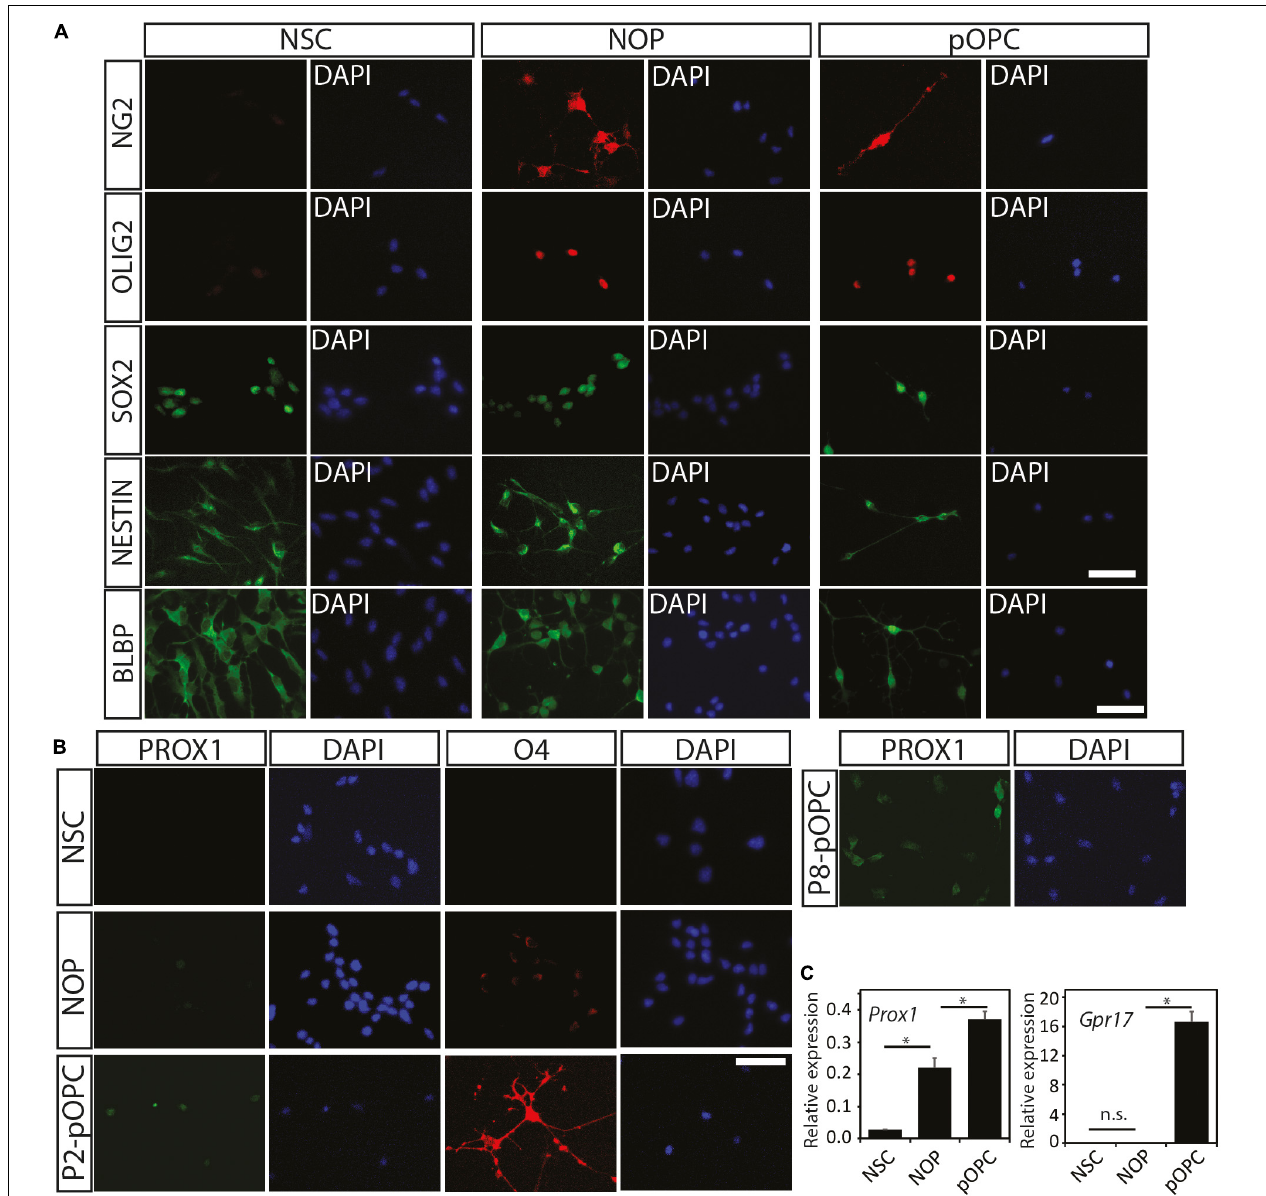
FIGURE 2 | Expression of oligodendroglial lineage markers among NSC, NOP, and pOPC. (A) Representative images of immunofluorescent staining for progenitor cell and oligodendroglial lineage marker proteins in NSC, NOP, and pOPC: NG2 (OPC marker); OLIG2 (pan-oligodendrocyte lineage cell marker); SOX2, NESTIN, and BLBP (stem/progenitor cell markers). Scale bar: 50 µ m. (B) Representative images of PROX1 and O4 signals in NSC, NOP and pOPC (both P2 and P8). Scale bar: 50 µ m. (C) qPCR based quantification of Prox1 and Gpr17 gene expression among NSC, NOP and P2-pOPC. Data are mean ± SD (bars) of